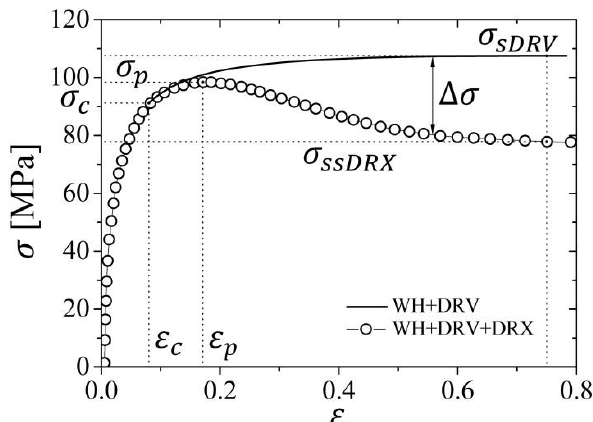
Figure 1. Schematic of hot working compression curves. DRX, dynamic recrystallization; DRV, dynamic recovery; WH, work hardening.